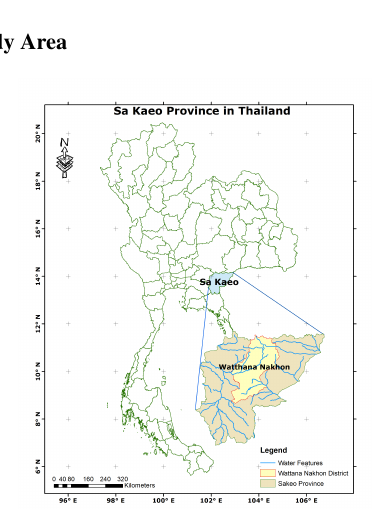
Figure 1: Map of the Sa Kaeo Province and Watthana Nakhon